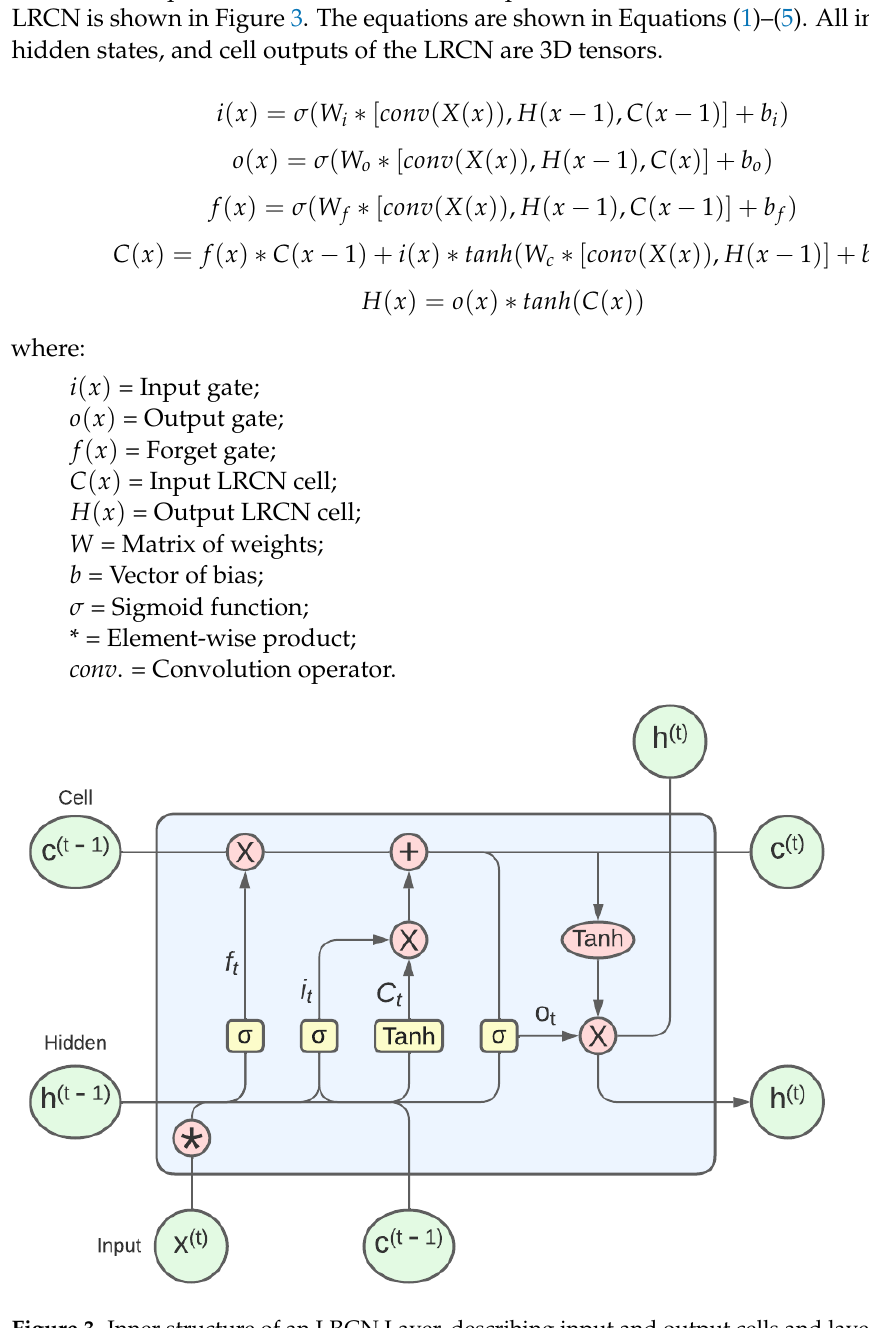
Figure 3. Inner structure of an LRCN Layer, describing input and output cells and layer